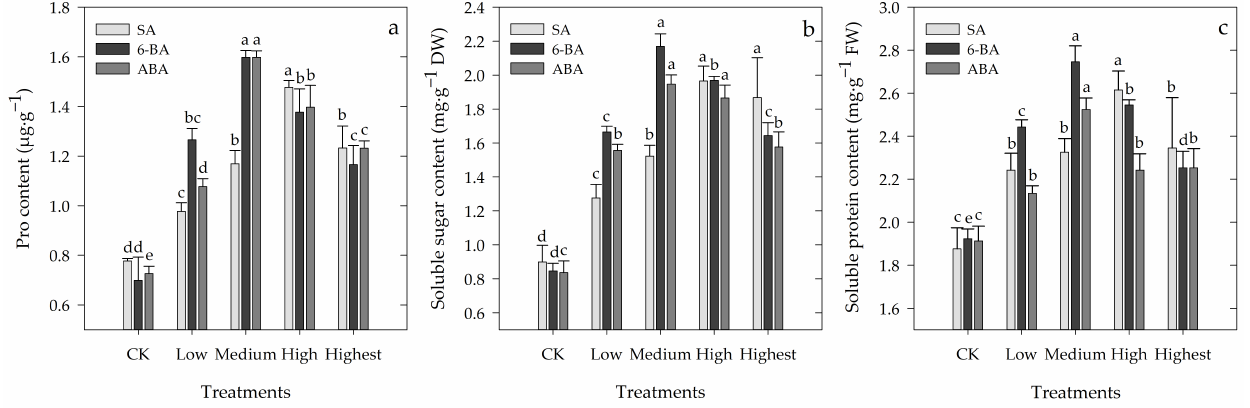
Figure 6. Effects of different concentrations of SA, 6-BA or ABA on the contents of the osmoregulatory substances proline ( a ), soluble sugars ( b ) and soluble proteins ( c ) of Rosa hybrida ‘Carolla’. CK: distilled water. Low, 0.5 mmol · L − 1 SA, 10 µ mol · L − 1 6-BA, 37.5 µ mol · L − 1 ABA; medium: 1.0 mmol · L − 1 SA, 20 µ mol · L − 1 6-BA, 75 µ mol · L − 1 ABA; high: 1.5 mmol · L − 1 SA, 30 µ mol · L − 1 6-BA, 112.5 µ mol · L − 1 ABA; highest: 2.0 mmol · L − 1 SA, 50 µ mol · L − 1 6-BA, 187.5 µ mol · L − 1 ABA; Vertical bars denote significant differences ( p < 0.05) according to Duncan’s multiple range